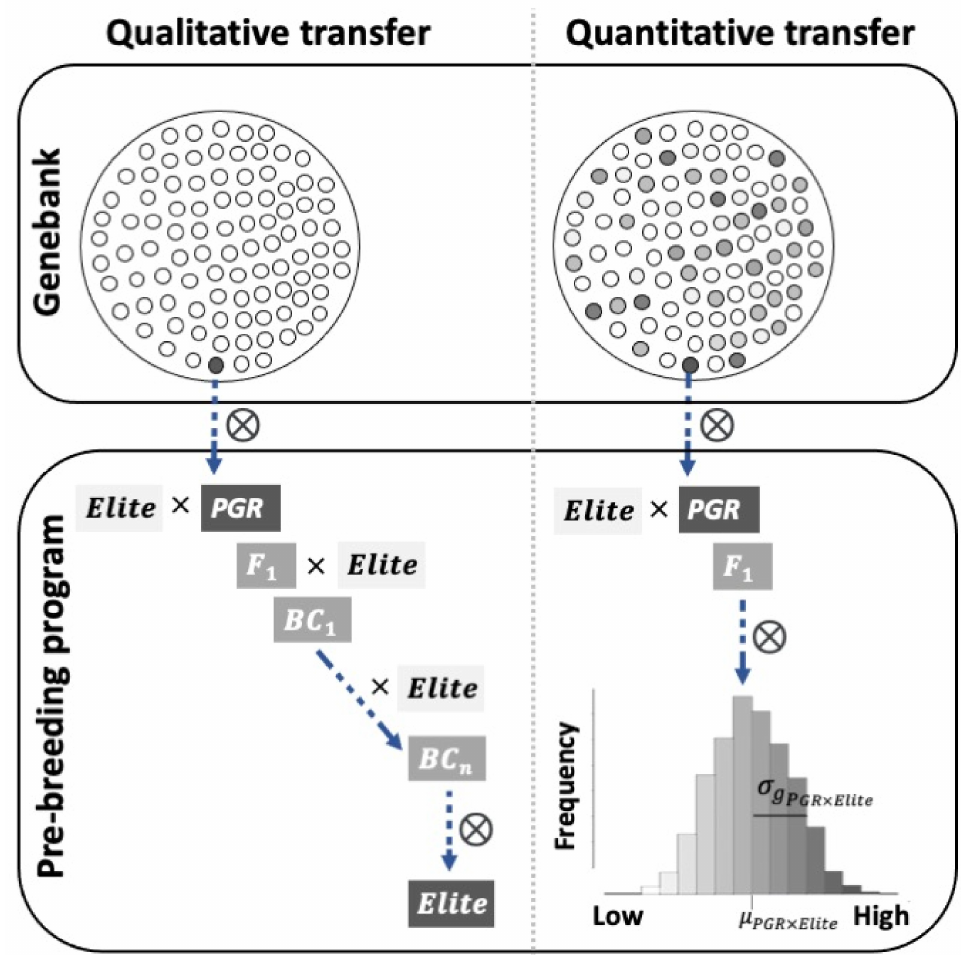
Figure 2. Strategies for introgressing variation from plant genetic resources (PGR) into (pre-)breeding programs to confer traits with simple ( left ) and polygenic ( right ) genetic architecture. For simple traits, backcrosses (BC) are commonly used for trait introgression. For polygenic traits, progeny selec- tion within segregant inbred populations from F 1 crosses is a common method for trait introgression. Each segregant inbred population is characterized by its mean ( µ PGR × Elite ) and genetic standard deviation ( σ g ). The different shades of gray represent different values of trait variation at all PGR × Elite levels of the